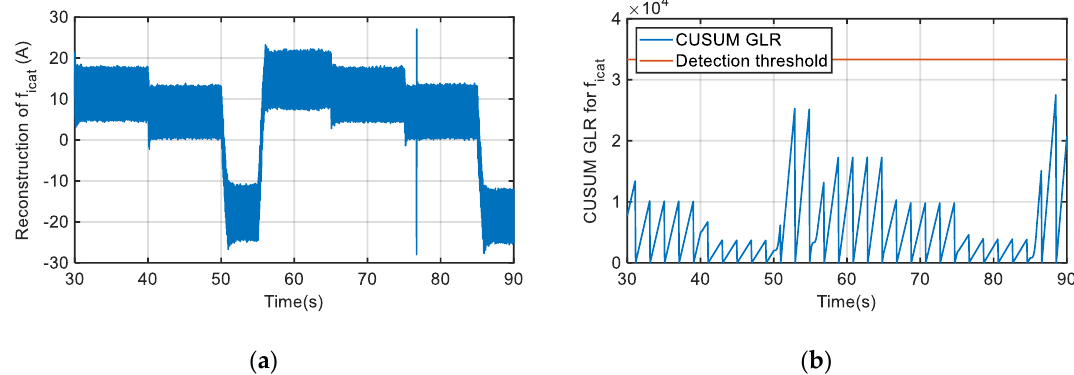
Figure13. Gainfaultinjectionincatenarycurrentsensor. ( a )Catenarycurrentsensorfaultreconstruction. Figure 13. Gain fault injection in catenary current sensor. ( a ) Catenary current sensor fault reconstruction. ( b ) ( b ) cumulative sum (CUSUM) GLR cumulative sum (CUSUM) GLR calculation.